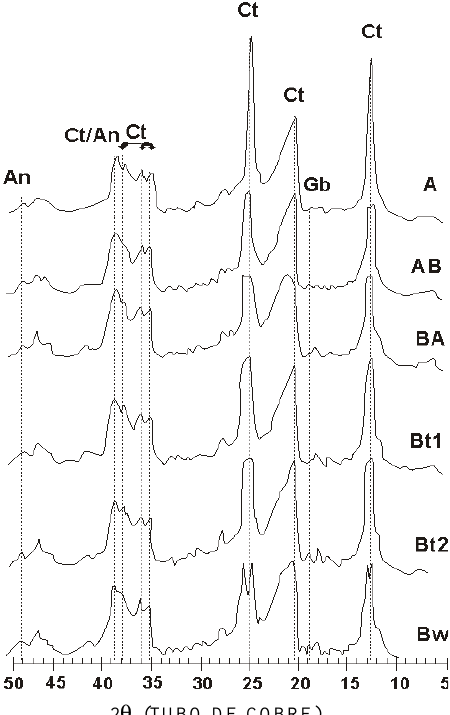
2 θ (TUBO DE COBRE) Figura 4. Difratogramas de raios-X da fração argila desferrificada do Argissolo Amarelo distrófico latossólico - PAd1(lâminas em pó). Ct - caulinita; Ct/An - caulinita/anatásio e An - anatásio.